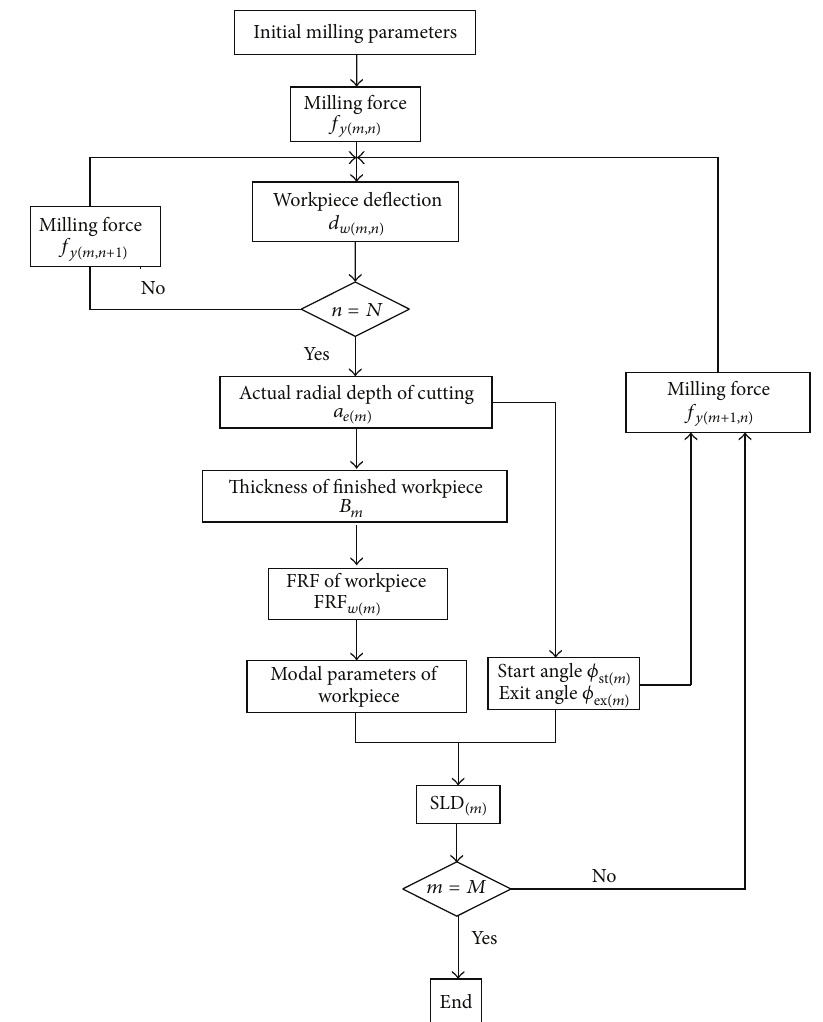
Figure 1: Computational flow of